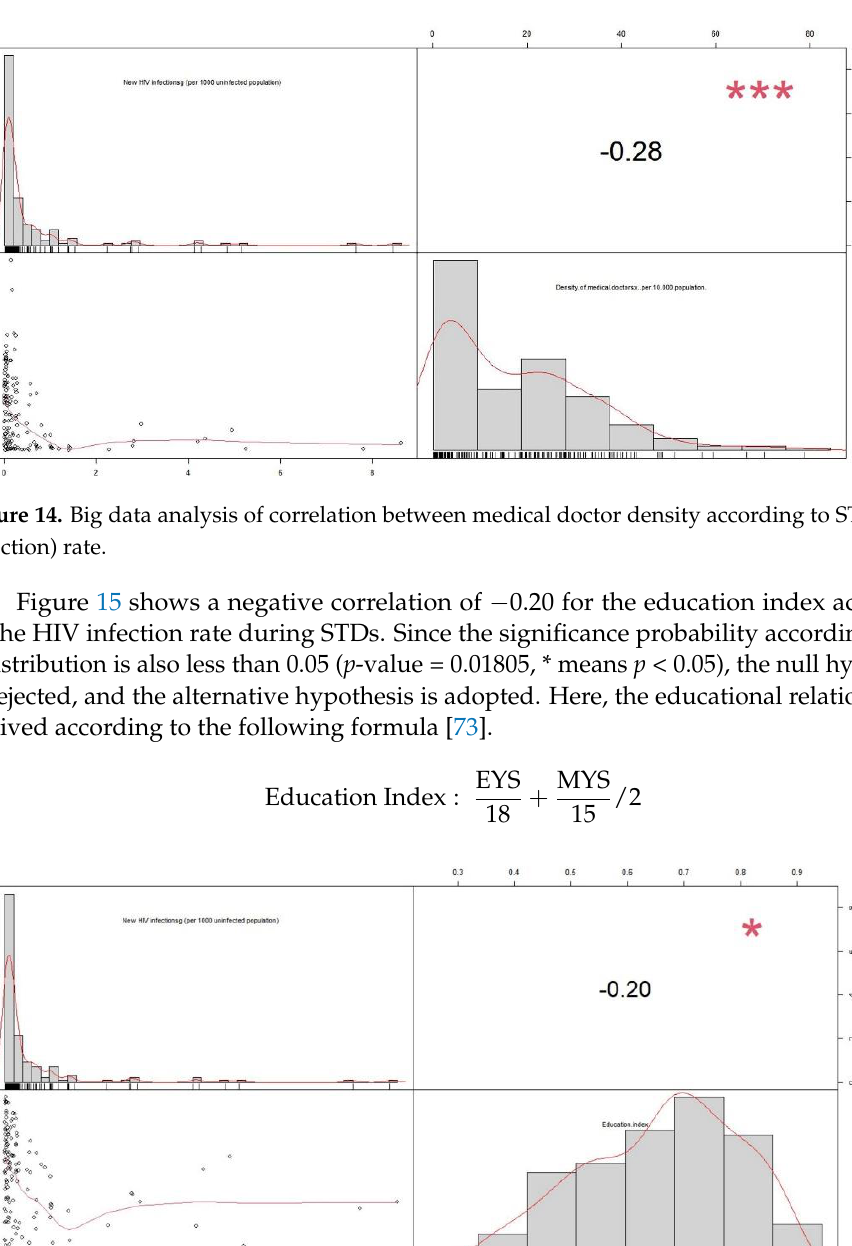
Figure 13. Big data analysis of correlation between life expectancy according to STDs (HIV infection) rate.